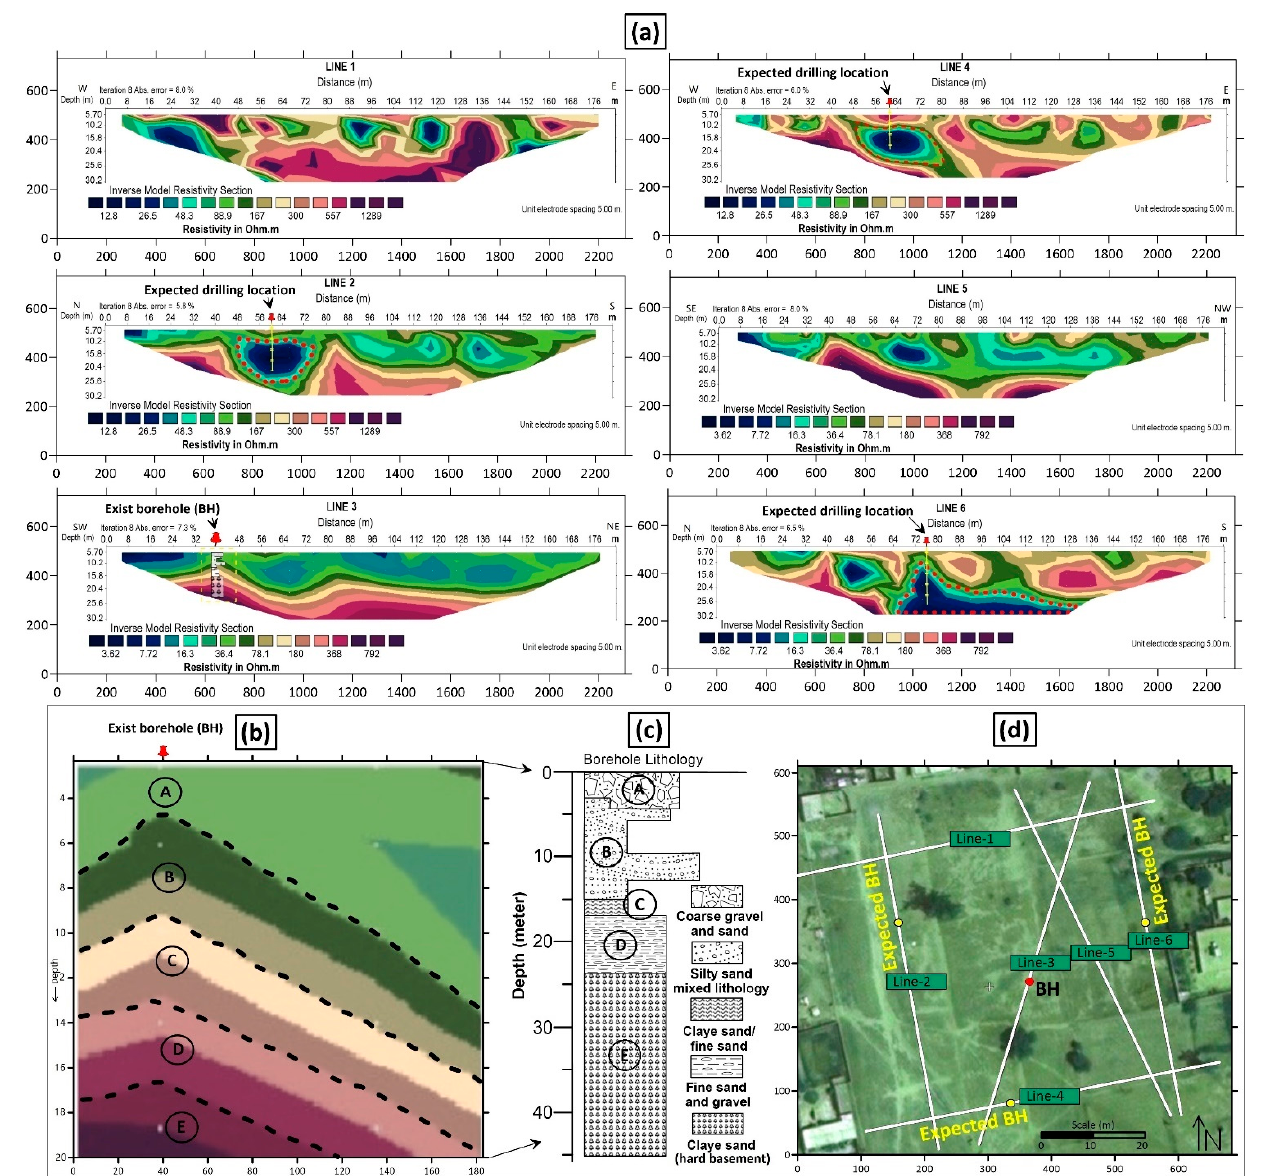
Figure 9. ( a ) Inverse model resistivity section of ERT survey lines (i.e., L1, L2, L3, L4, L5, and L6) containing existing borehole lithological information on L3; ( b ) correlation of acquired ERT hydrologic stratigraphy with ( c ) The existing borehole lithological information; and ( d ) ERT measurements line alignment in the study area, in which the red dot shows the location of the existing borehole, and the yellow dots indicate the proposed locations of wells for groundwater exploi- tation.